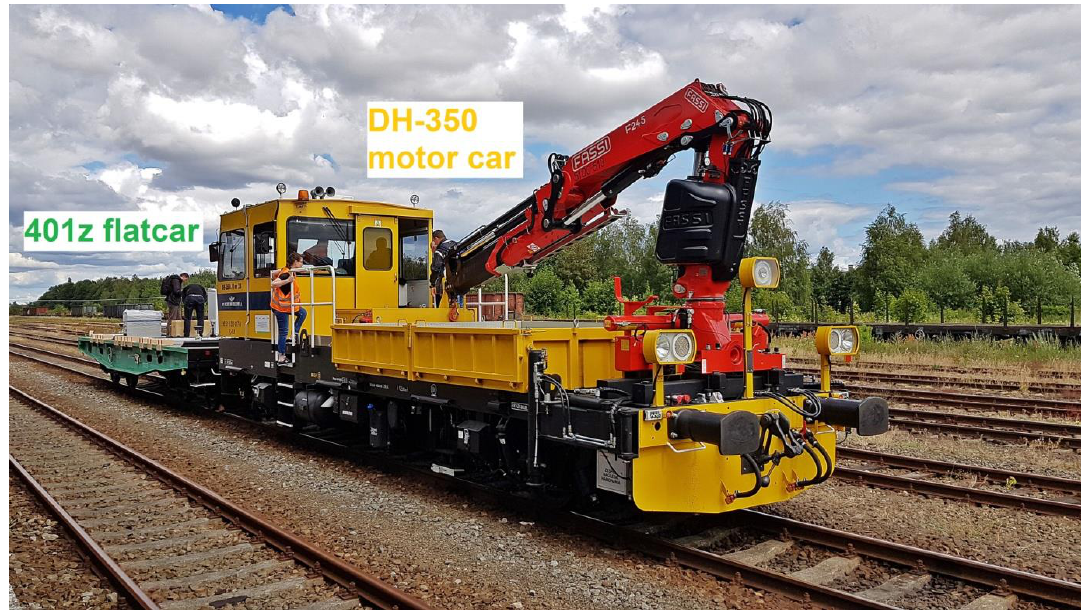
Figure 5. Measuring set number 3 for making mobile satellite measurements.